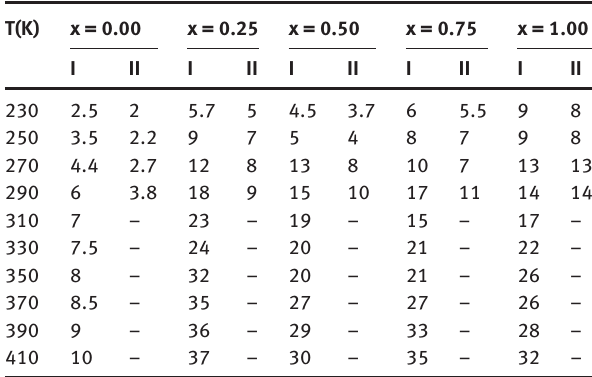
Table 2: The calculated De values for all the samples T(K) x = 0.00 x = 0.25 x =